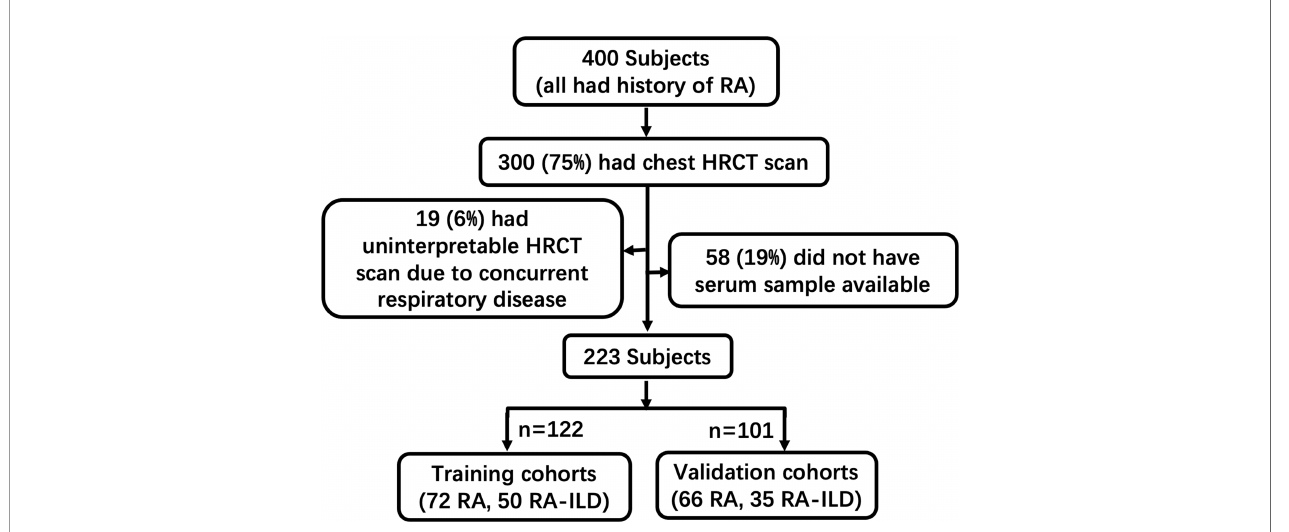
FIGURE 1 | Work fl ow of sample collection in this study. Patients enrolled in this study were categorized by clinical diagnostic data and HRCT patterns in this study.